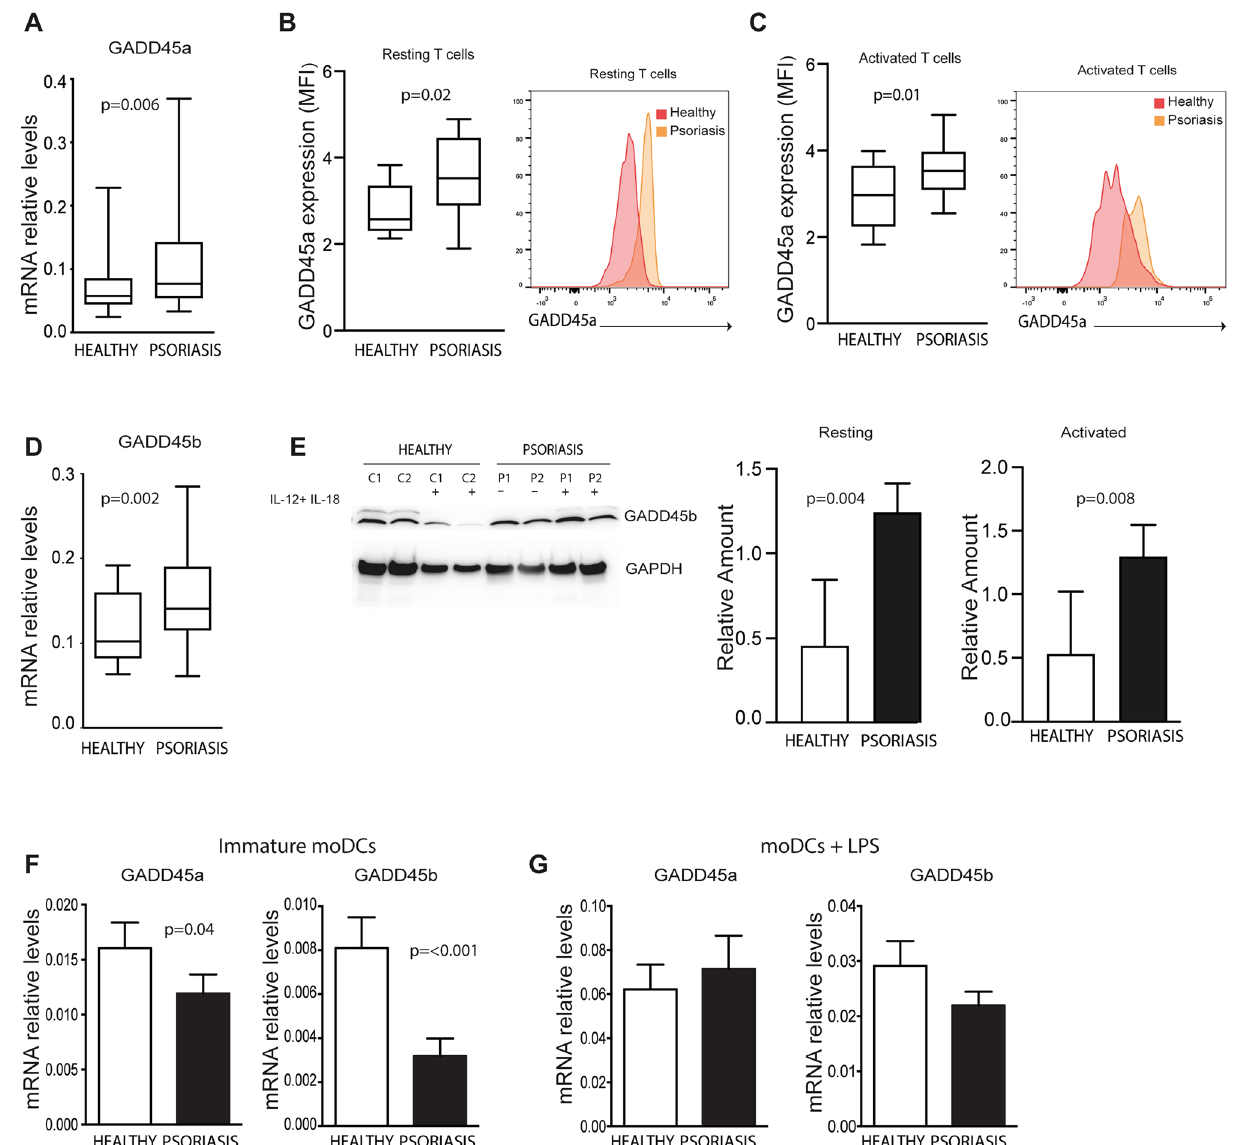
Figure 3. Differential expression of GADD45a and GADD45b in peripheral blood leucocytes from psoriasis patients and healthy subjects. ( A ) Box charts show mRNA expression of GADD45a in unstimulated CD4 + T cells from psoriasis patients (n = 20) and controls subjects (n = 15). Expression was analyzed using qRT-PCR and GAPDH was used to normalize data. ( B ) Box charts show the expression of GADD45a in resting T cells from psoriasis patients (n = 14) and controls (n = 9). ( C ) Box charts show the expression of GADD45a in activated T cells from psoriasis patients (n = 14) and controls (n = 9). PBLs were incubated in the presence of anti-CD3/ CD28 for 16 h, then GADD45a expression was evaluated by flow cytometry on CD3 + T cells. B-C , Data correspond to mean fluorescence intensity (MFI) of GADD45a expressed on gated CD3 + T cells. Representative histograms are shown. ( D ) GADD45b expression in unstimulated CD4 + T cells as in A. ( E ) Expression of GADD45b in total lysates of monocyte-free PBLs from psoriasis patients. Cells were incubated 24 h in the presence or absence of a mixture of IL-12 and IL18 (10 ng/ml). Representative blots from 2 out 6 patients and 2 out of 6 controls, and densitometric quantifications are shown. Bar charts show relative levels of GADD45b (data normalized to GADPDH). ( F ) Bar charts show GADD45a and GADD45b mRNA expression levels in immature moDCs analyzed using qRT-PCR. GAPDH was used to normalize data. ( G ) Expression of GADD45a and GADD45b mRNA in moDCs after 24 h of stimulation with LPS (10 ng/ml). Differences between groups were determined using Mann–Whitney U